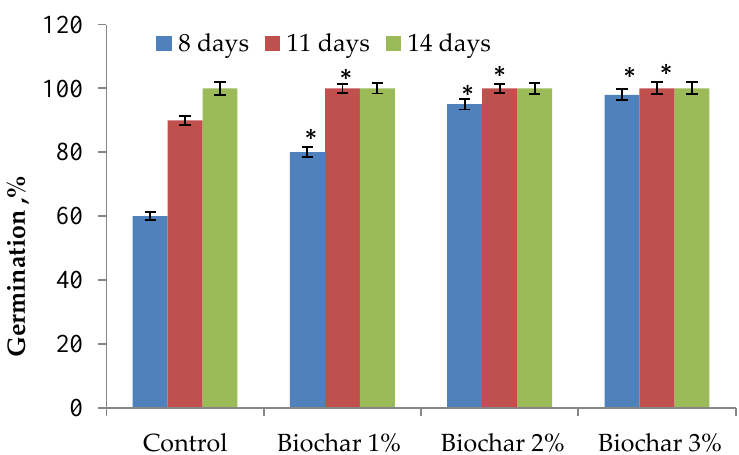
Figure 1. The impact of biochar concentrations on germination of ginger. Data are means of three replicates ( n = 3), asterisks indicate significant differences from the control at p < 0.05. The 2% biochar treatment increased plant height by 53% compared to the control, and the 3% biochar treatment showed a 78% increase compared to the control treatment. The 2% and 3% biochar treatments also showed that leaf length increased by 36% and 57%, respectively, compared to the control. The leaf number increased significantly with increasing addition of biochar up to 85% compared to the control (Table 2). The leaf width also improved significantly with the addition of 2% and 3% biochar by 54% and 73% as compared to the control. Table 2. The impact of biochar concentrations on plant height, leaf length, leaf number, and leaf width of ginger.